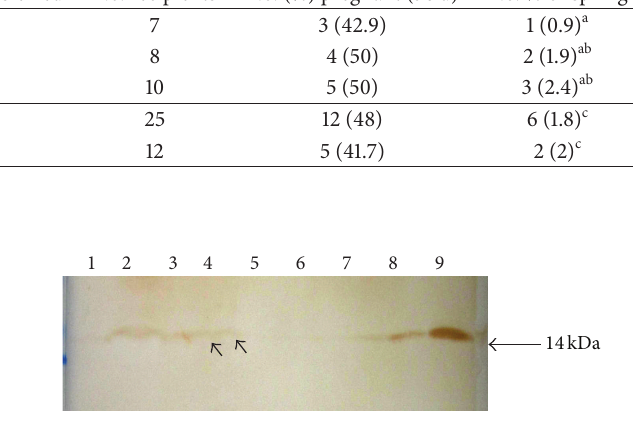
Figure 2: Expression of recombinant human alpha-lactalbumin (rhLA) in the supernatant of transgenic CMGECs. The result of Western blot. Lane 1: NT CMGECs control; lanes 2–5: supernatant of transgenic CMGECs; lanes 6–9: